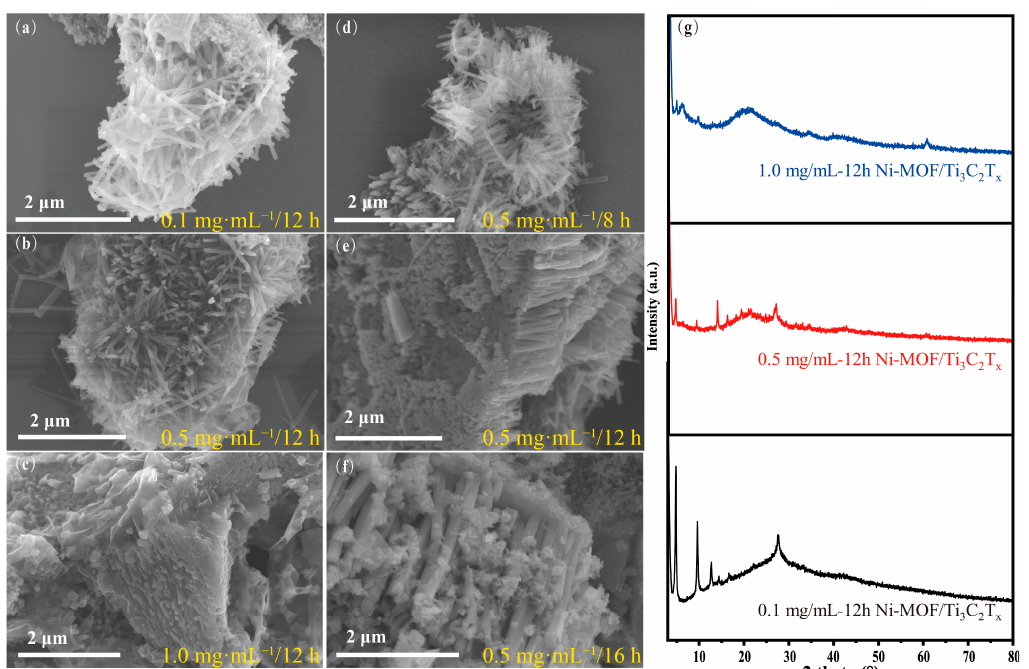
Figure 3. ( a – c ) SEM images of the Ni-MOF/Ti 3 C 2 T x samples within the same 12 h reaction time at different Ti 3 C 2 T x concentrations of 0.1 mg·mL − 1 , 0.5 mg·mL − 1 , and 1.0 mg·mL − 1 , respectively; ( d – f ) SEM images of the Ni-MOF/Ti 3 C 2 T x products at the same concentration 0.5 mg·mL − 1 of Ti 3 C 2 T x within different reaction times of 8 h, 12 h, and 16 h, respectively; and ( g ) XRD pattern of the Ni- MOF/Ti 3 C 2 T x samples grown at different Ti 3 C 2 T x concentrations.